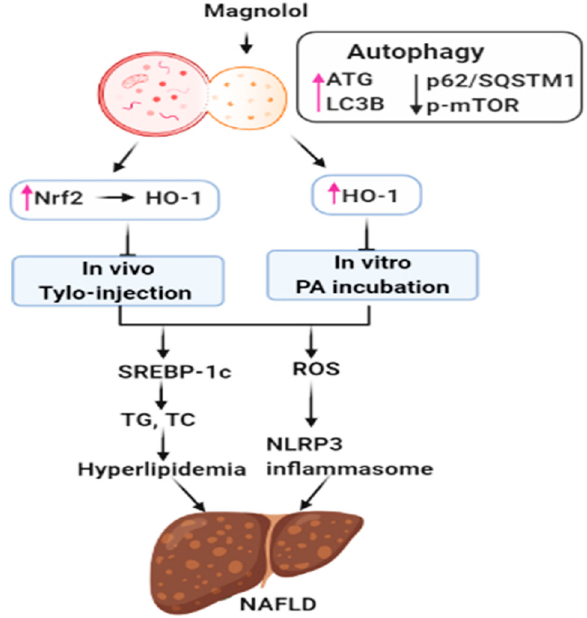
Figure 8. Schematic depiction of the protective mechanisms of magnolol (MG) in tyloxapol- and palmitic acid-induced NAFLD. MG activates autophagy by upregulation of ATG5-12, ATG7, Beclin1, and LC3B and reduction of p62 / SQSTM1 and p-mTOR expression, which results in the activation of antioxidant Nrf2 / HO-1 signaling, thereby suppressing tyloxapol and palmitic acid (PA)-induced hepatic steatosis and inflammation. In addition, MG inhibits hyperlipidemia through downregulation of SREBP-1c, as well as ROS and NLRP3 inflammasome activation.